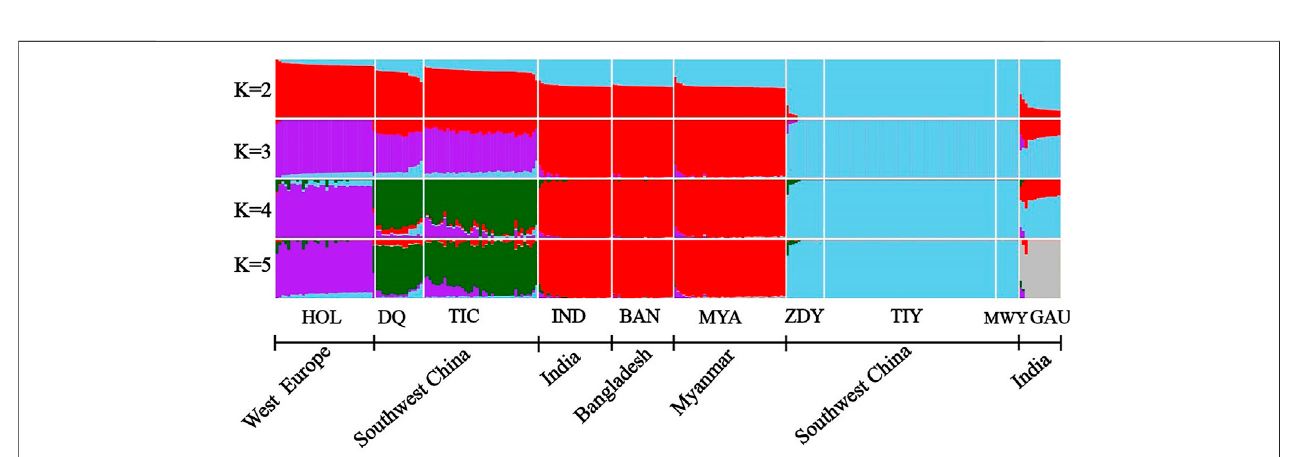
FIGURE 3 | ADMIXTURE analyses of 10 populations ( K = 2 – 5). The bovine population abbreviations are given in Table 1 .